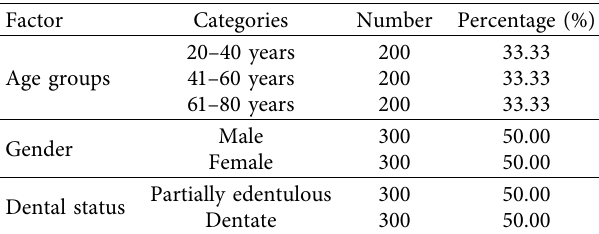
Figure 2: Measurement being carried out for the alveolar nerve loop using the measurement tool of standardized software. Table 1: Demographic characteristics and dentition status of the study